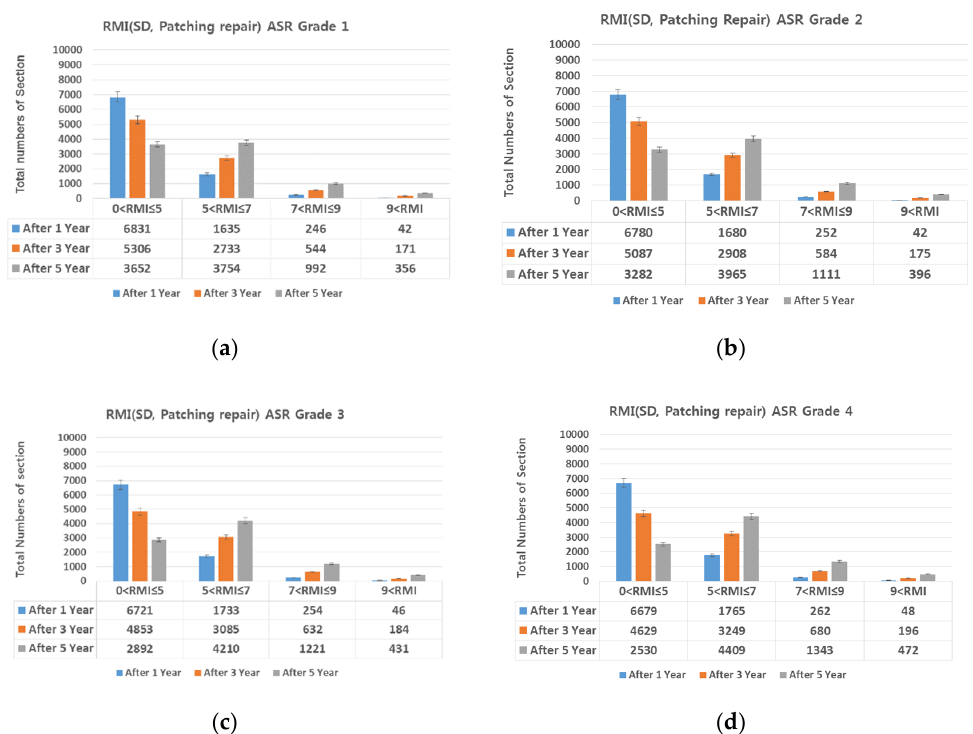
Figure 18. Change in number of sections per RMI with respect to SD. ( a ) patching repair and ASR grade 1; ( b ) patching repair and ASR grade 2; ( c ) patching repair and ASR grade 3; and ( d ) patching repair and ASR grade 4.